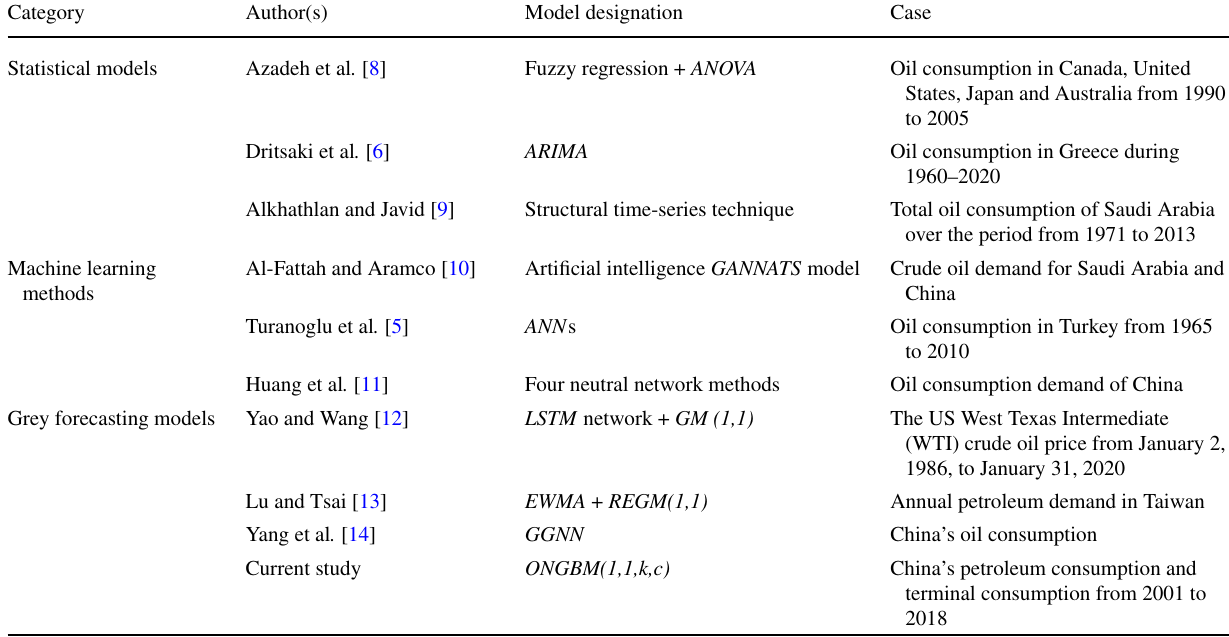
Table 1 Recent forecasting techniques for petroleum consumption